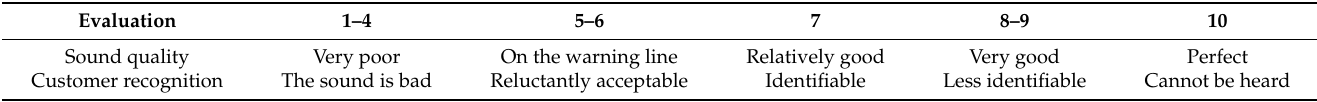
Table 2. Evaluation criteria of vehicle